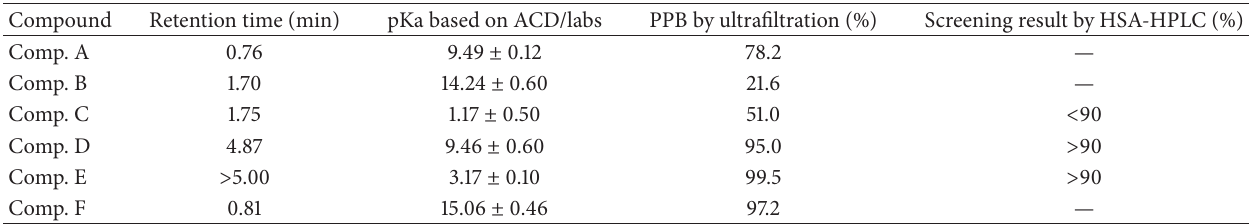
Table 2: Retention time, predicted pKa, experimental PPB, and result by HSA-HPLC of test